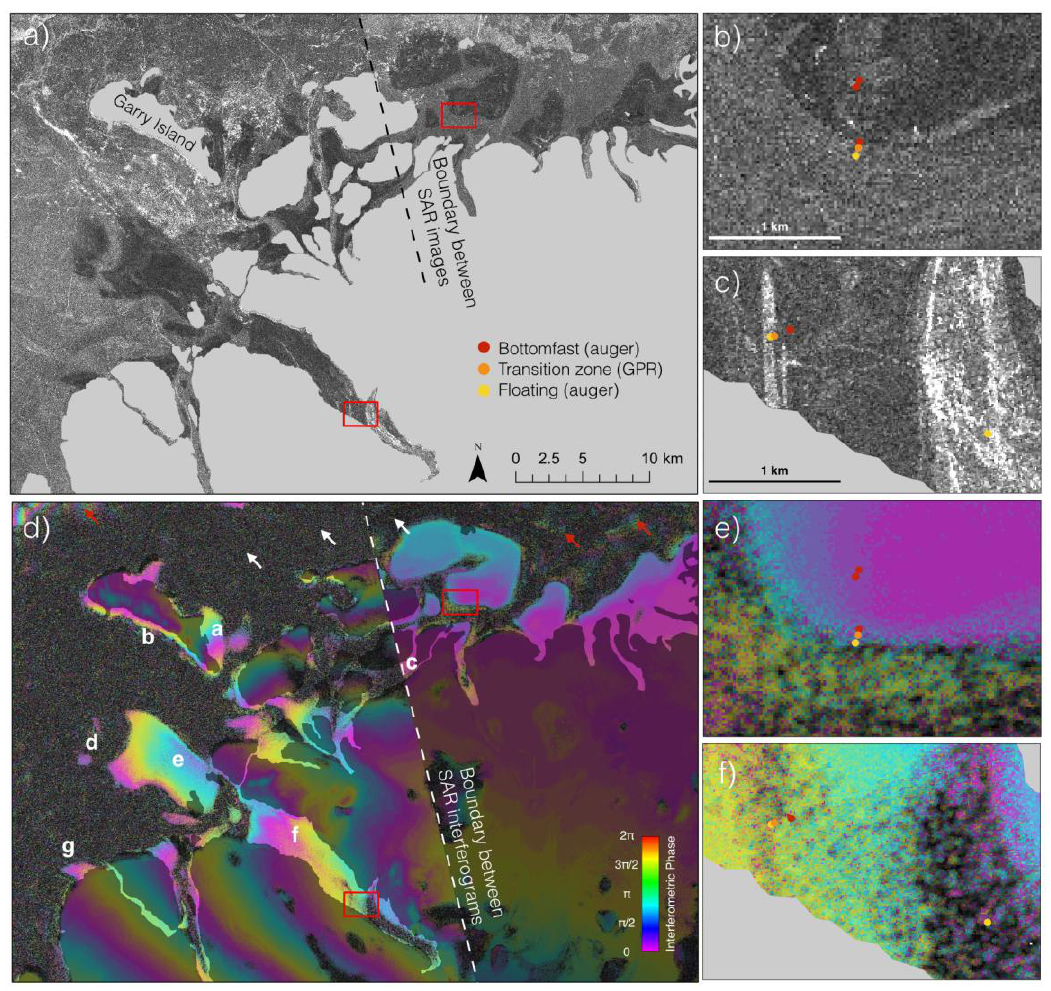
Figure 3. ( a ) Two PALSAR backscatter images acquired on 26 February 2010 (left) and 25 April 2010 (right) near Kendall Island, Mackenzie Delta; ( b , c ) Enlarged areas around in-situ measurements acquired on 25 April 2010 using auger and GPR; ( d ) Interferogram created using acquisitions from 10 March and 25 April 2010 (right) and 11 January and 26 February 2010 (left); ( e , f ) Enlarged areas around in-situ measurements.